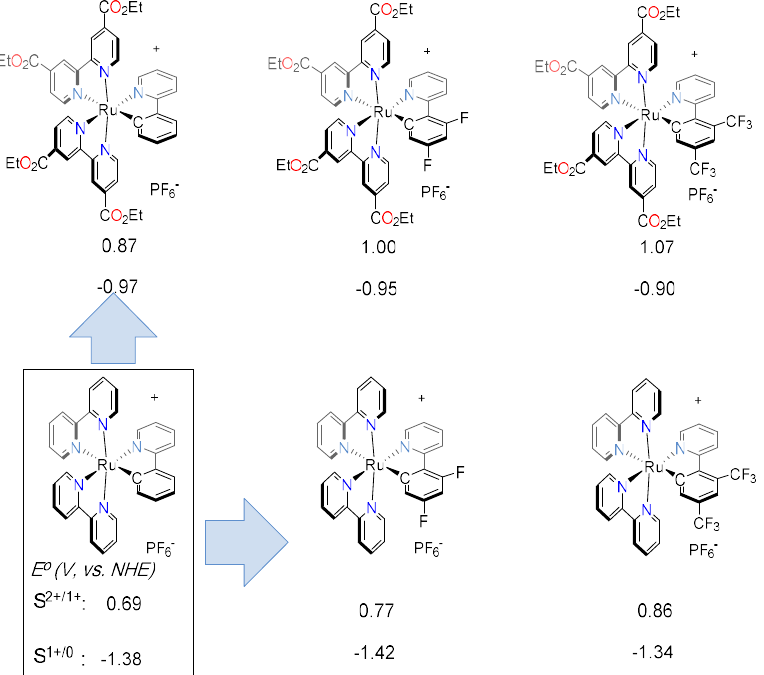
Figure 13. The change in first oxidation and reduction potential of cyclometalated ruthenium complexes upon introduction of electron-withdrawing substituents on both cyclometalating and bipyridine ligands. Oxidation potential values are taken from literature and were obtained in 0.1 M acetonitrile solution of LiClO 4 [118] .